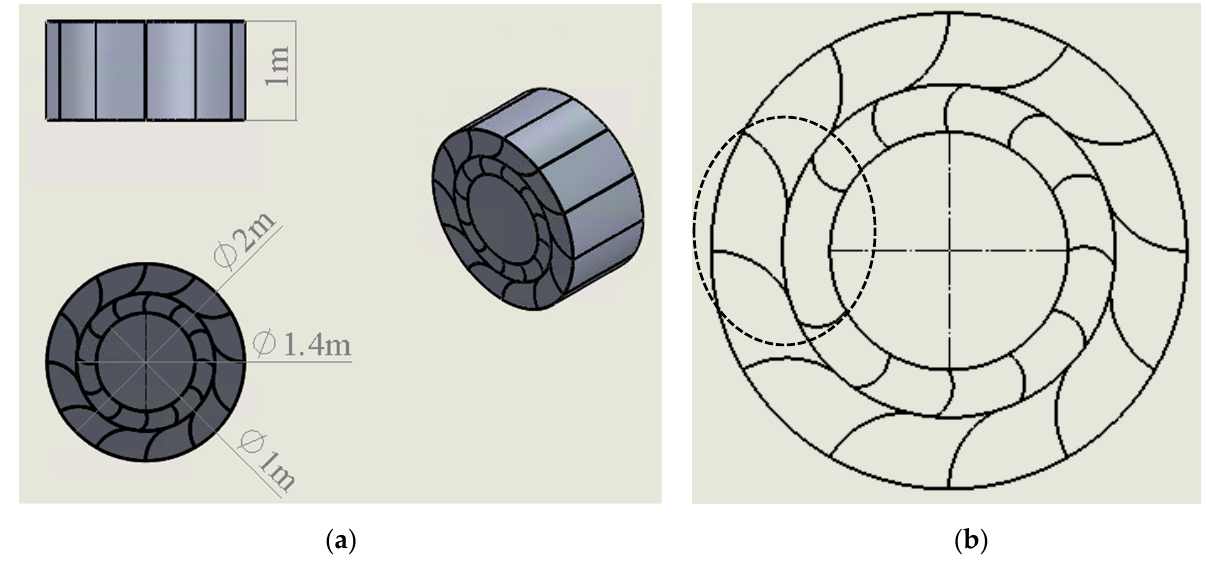
Figure 1. Geometry of the VAWT models. ( a ) Healthy. ( b ) Damaged.